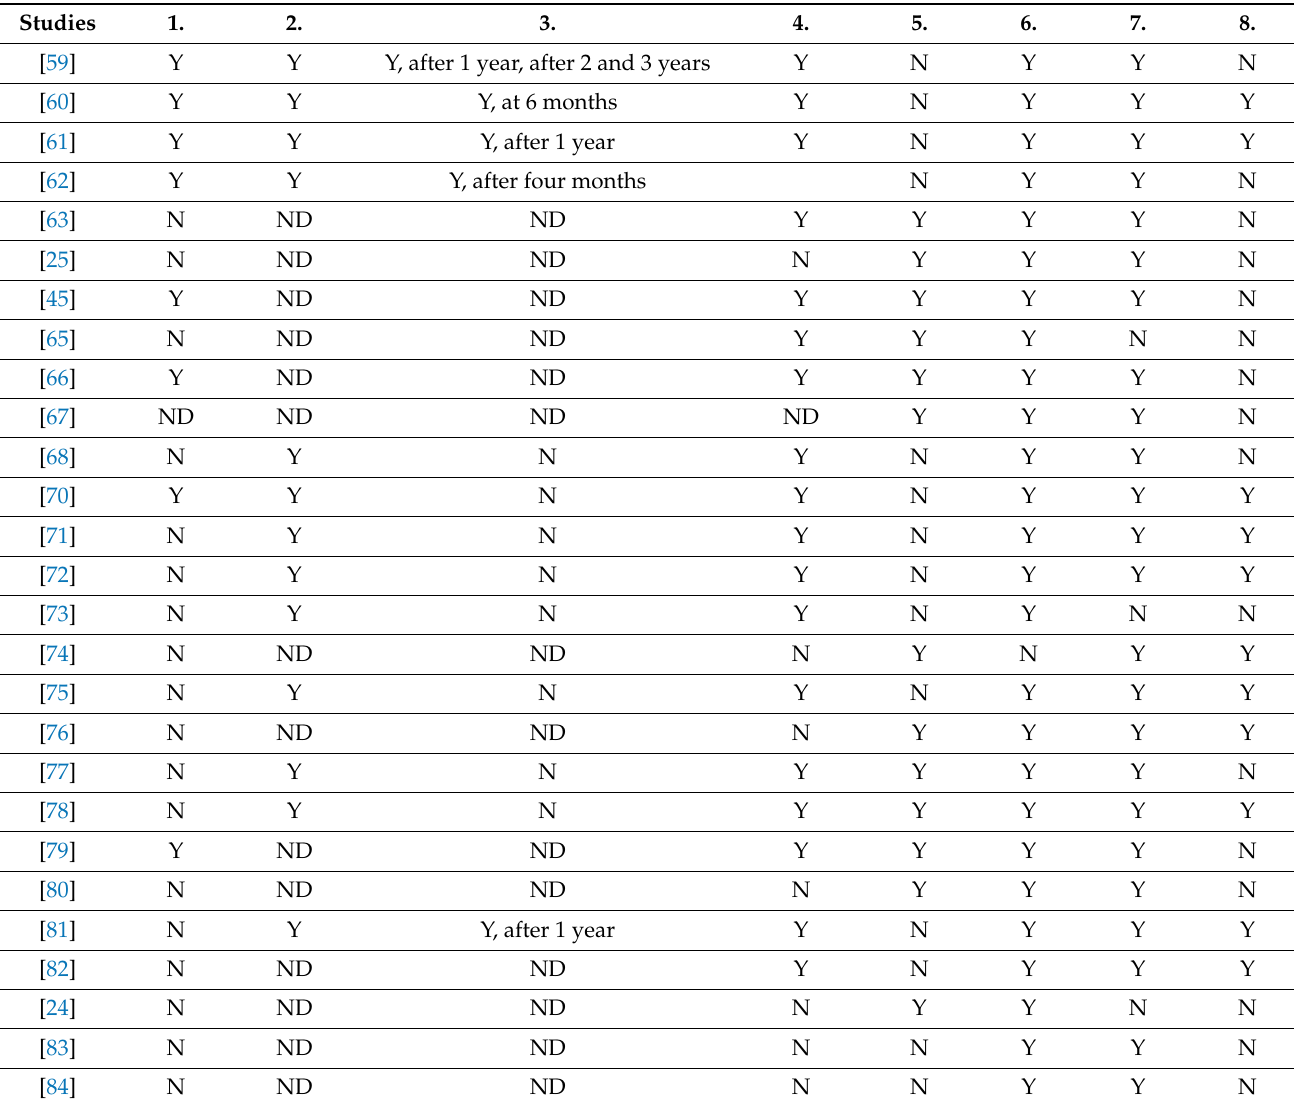
Table 4. The evaluation criteria of strong evidence data confirming the effectiveness of WHPIs from an empirical review.